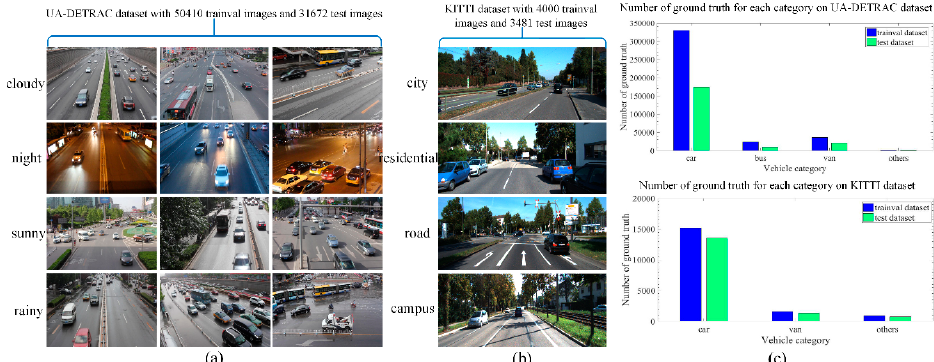
Figure 4. Different datasets for vehicle detection. (a) UA ‐ DETRAC dataset: We classify the vehicles into four categories (i.e., car, bus, van, and others) with multiple scales, occlusion ratios and truncation ratios in each weather condition; (b) KITTI dataset: We classify the vehicles into three categories (i.e., car, van, and others) with different degrees of occlusion and truncation in multiple scenes; (c) Number of ground truth for each category on UA ‐ DETRAC dataset and KITTI dataset, respectively.